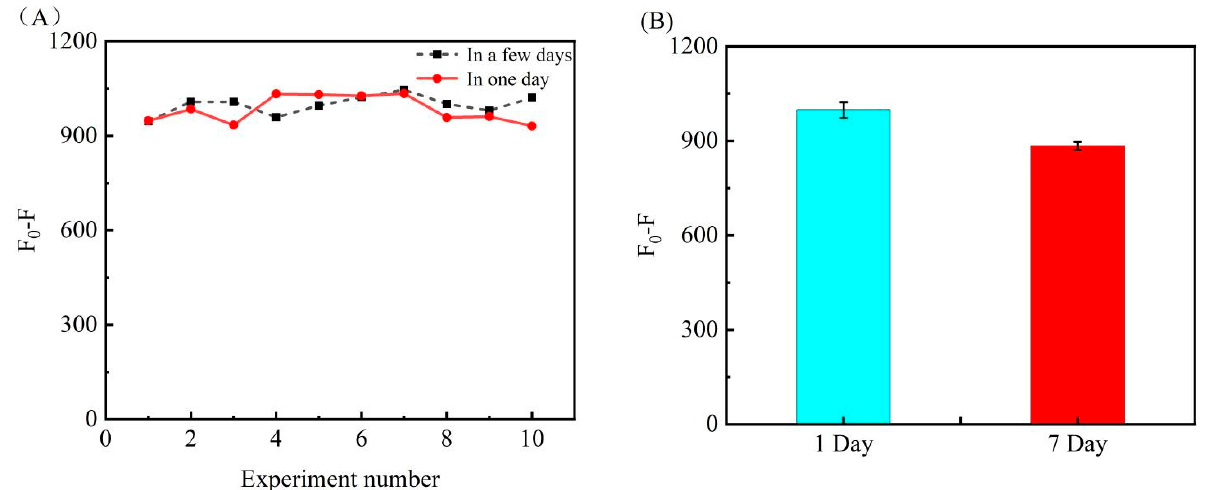
Figure 6. ( A ) is a dot-line graph obtained from repeated experimental data, the black in the figure is the results of 10 groups of experiments carried out on different days; the red curve is the results of 10 groups of experiments carried out in one day. ( B ) In order to test the stability of the bioconjugate (AuNPs-DNA and SIBs-DNA), the measured data were tested three times. The left side is the experimental result of the first day, and the right side is the seventh day of the experiment. The results obtained.